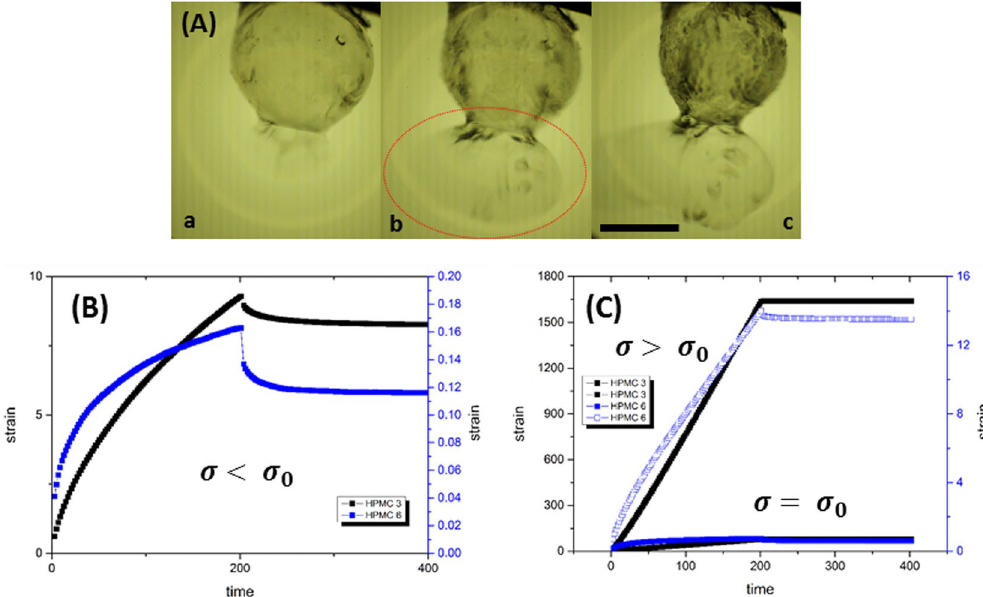
Figure 2. ( A ) Sequential process of elongation, thinning and yielding of the shell prior to rupture. (a) Bulging out of the shell from a weak sector causing stretching; t = 0 ms (b) ballooning of the bulged portion leading to severe stretching and possible yielding; thin sheet formation; 0.138 ms. (c) sheet rupture; 0.277 ms. Image sequence is for a burning ethanol gel droplet with 3 wt.% gellant loading. The scale bar equals 1 mm. Temporal variation of creep-strain as a function gellant loading rate for HPMC 3 and HPMC 6 at different shear ( σ ) loading conditions: ( B ) below yield point ( σ σ = < 10 Pa ), ( C ) at yield point and above yield point. 0